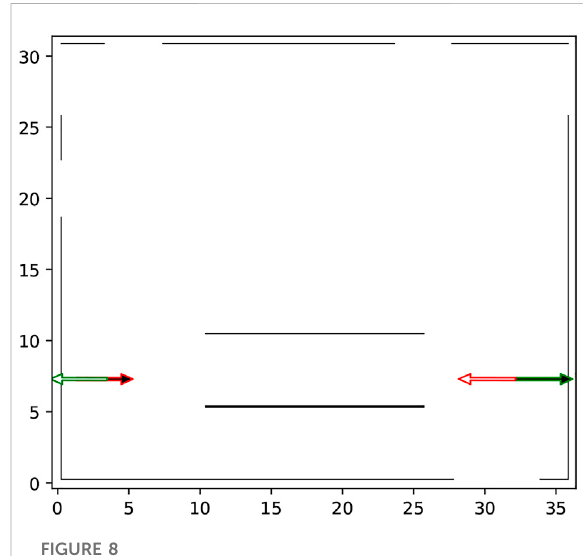
FIGURE 8 The occupancy map of the PedSim warehouse. The start and goal poses for the robot are outlined red and green, respectively. Both x and y axes are in meters.